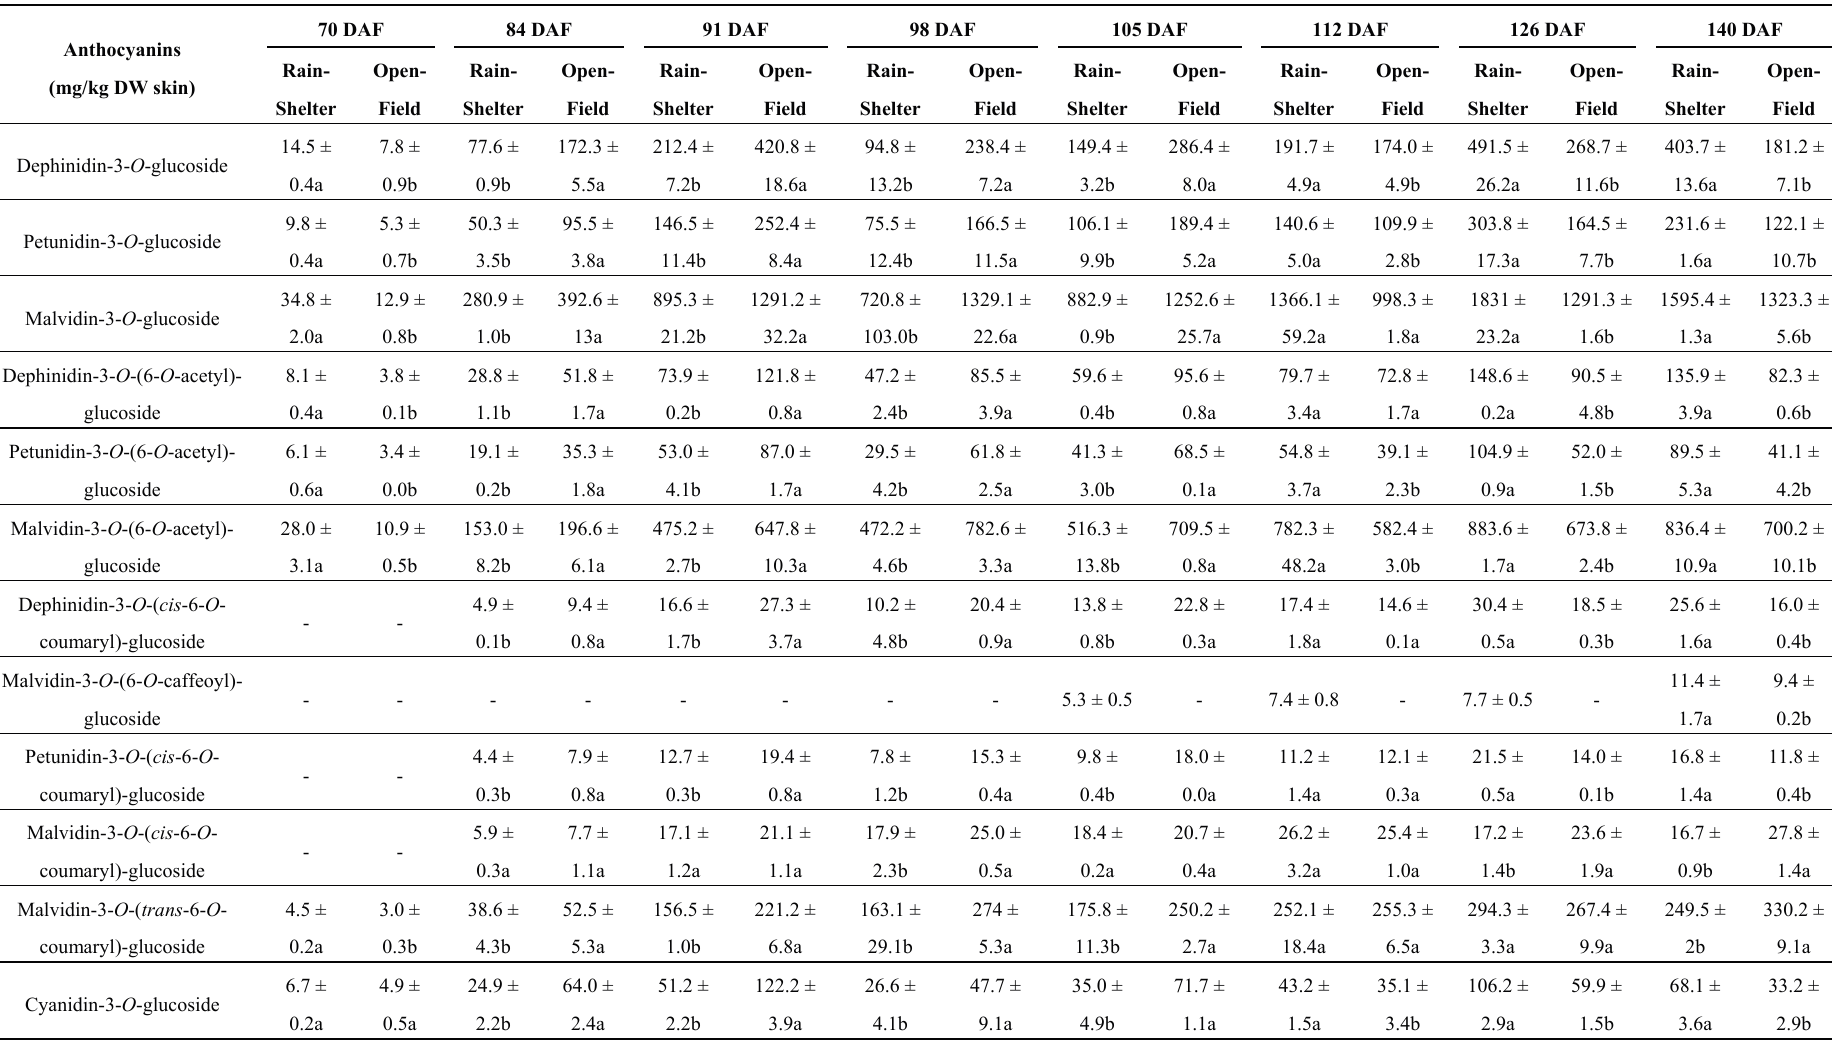
Table 1. Content of individual anthocyanins in grape skins under rain-shelter cultivation and open-field cultivation. Anthocyanins (mg/kg DW